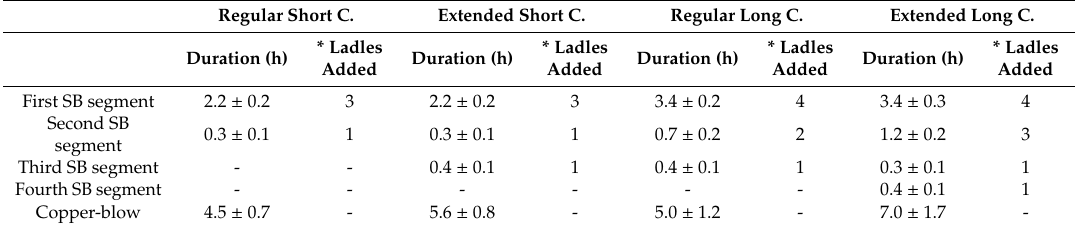
Table 4. Example of PS converting data, including short and long cycles that can be extended. Regular Short C.